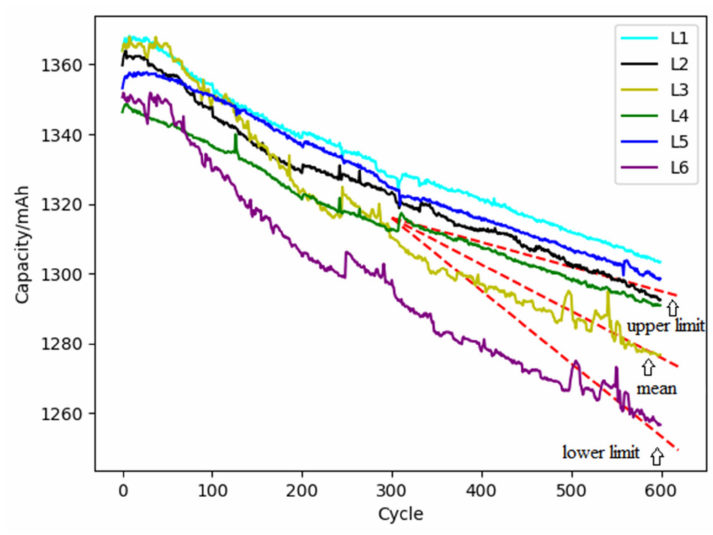
Figure 11. The prediction result of the dispersion of multiple battery degradation.